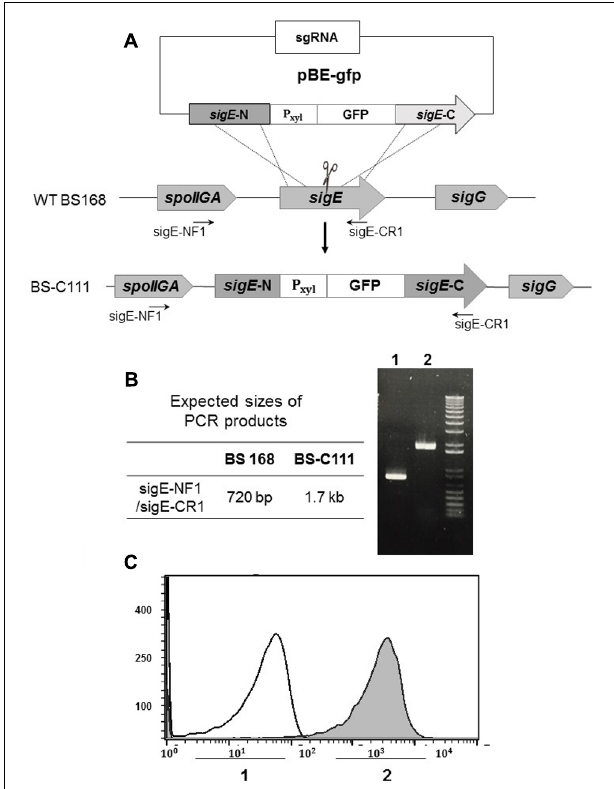
FIGURE 6 | Construction of green fluorescence protein (GFP) insertion in sigE . (A) Along with pHCas9, pBE-gfp was used to deliver sgRNA and the donor DNA template to generate GFP insertion in the sigE gene through HDR. (B) Insertion of P xyl -gfp was confirmed with PCR and (C) Guava InCyte flow cytometry assay; 1 indicates the B. subtilis 168 control; 2 is pBE-gfp-transferred